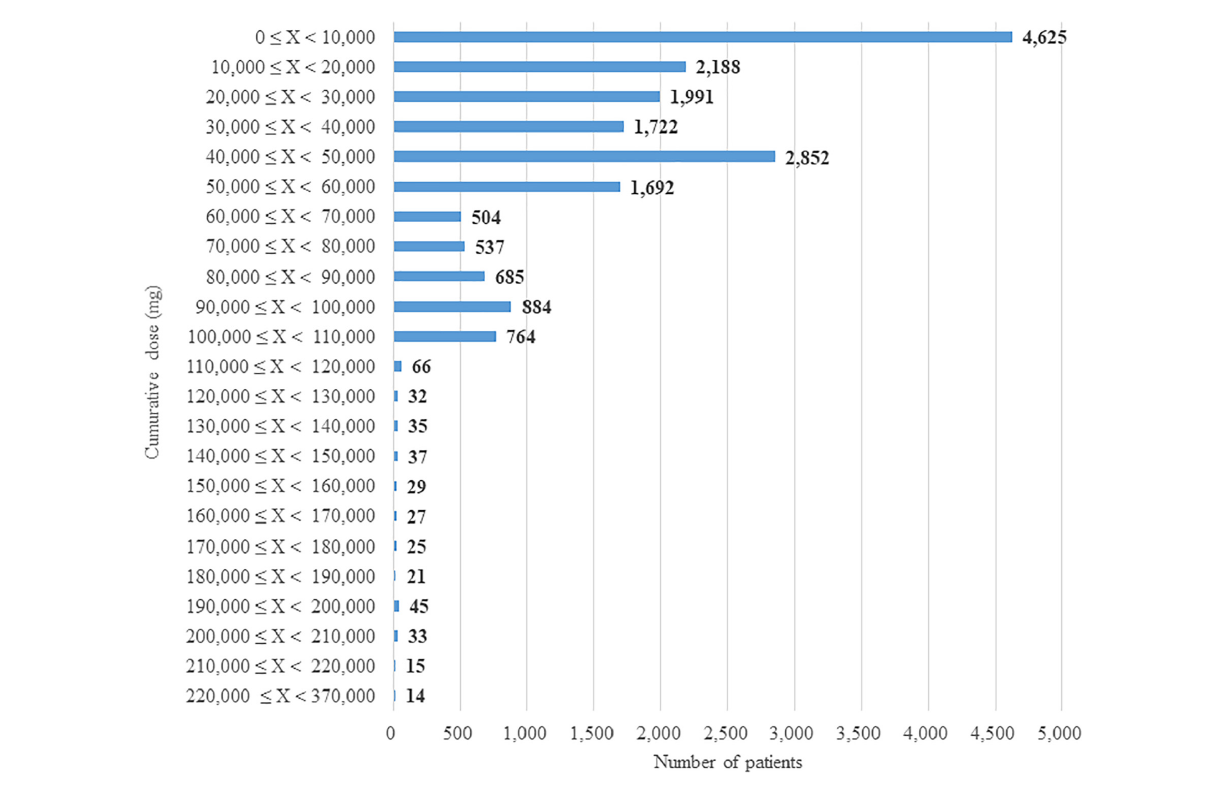
FIGURE1 Frequency distribution for cumulative dose of valsartan-containing